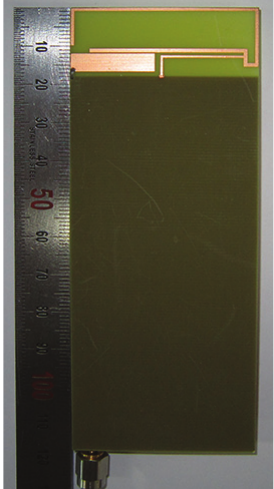
F 3: Fabricated prototype of the proposed